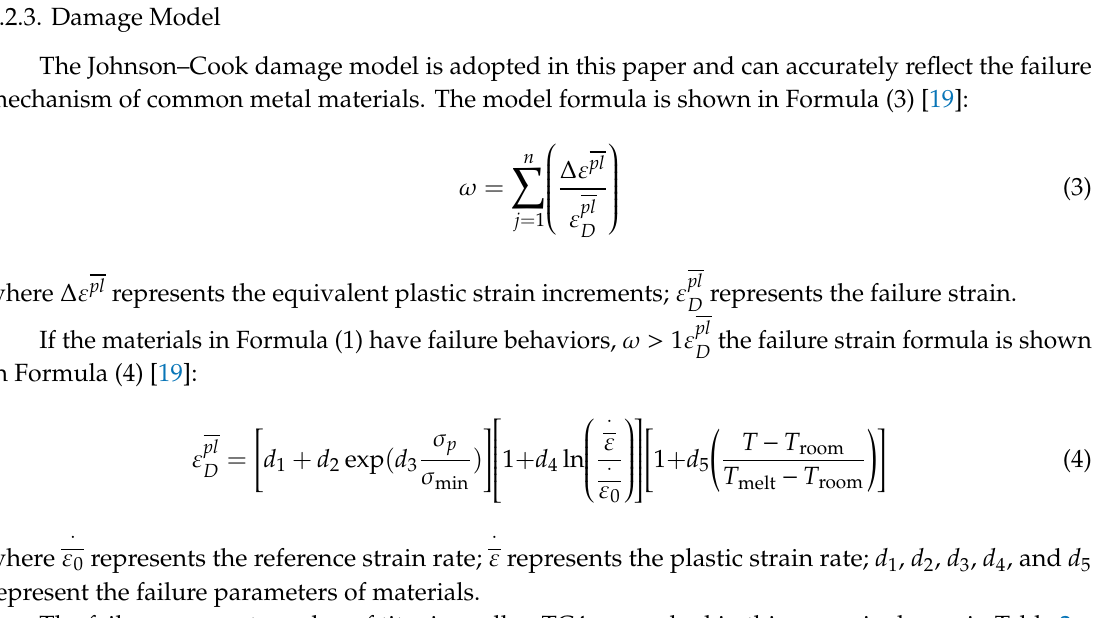
Figure 2. Temperature-related friction model ( a ) Stress distribution of tool-cuttings contact surface ( b ) Relationship between friction coe ffi cient and temperature.